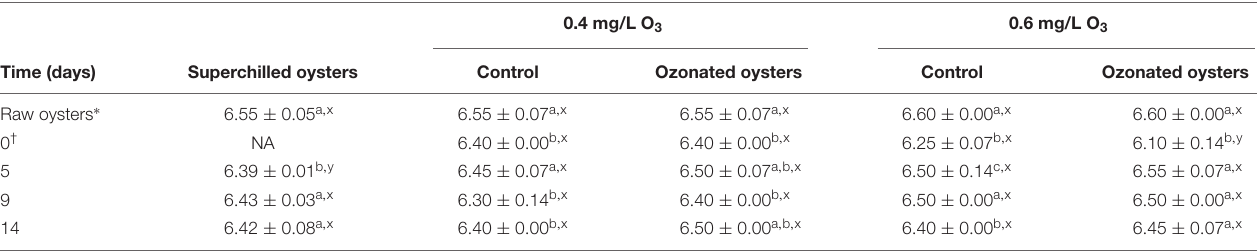
TABLE 6 | Changes in pH values in naturally contaminated American oyster ( Crassostrea virginica ) superchilled only and depurated with ozonated seawater and superchilled stored at − 1 ◦